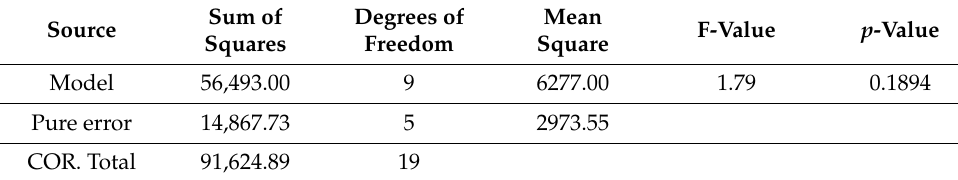
Table 4. Analysis of Variance for oil loss